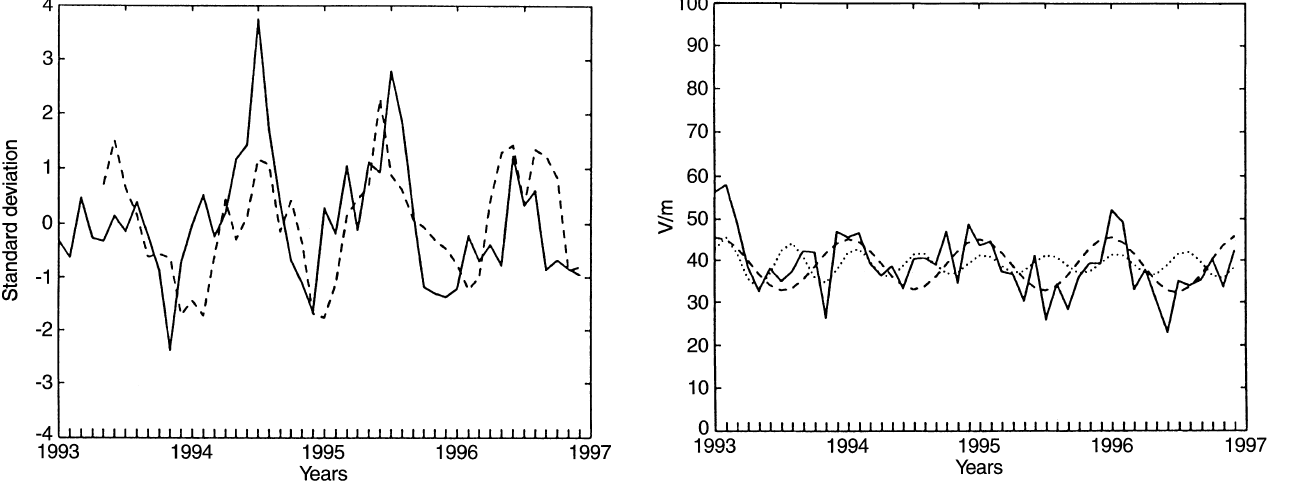
Fig. 4. Normalised di(cid:128)erences between day-time and night-time monthly means of the PG ( solid line ) and average SR amplitudes for the first three modes ( dashed line ) for the same interval as in Fig. 2